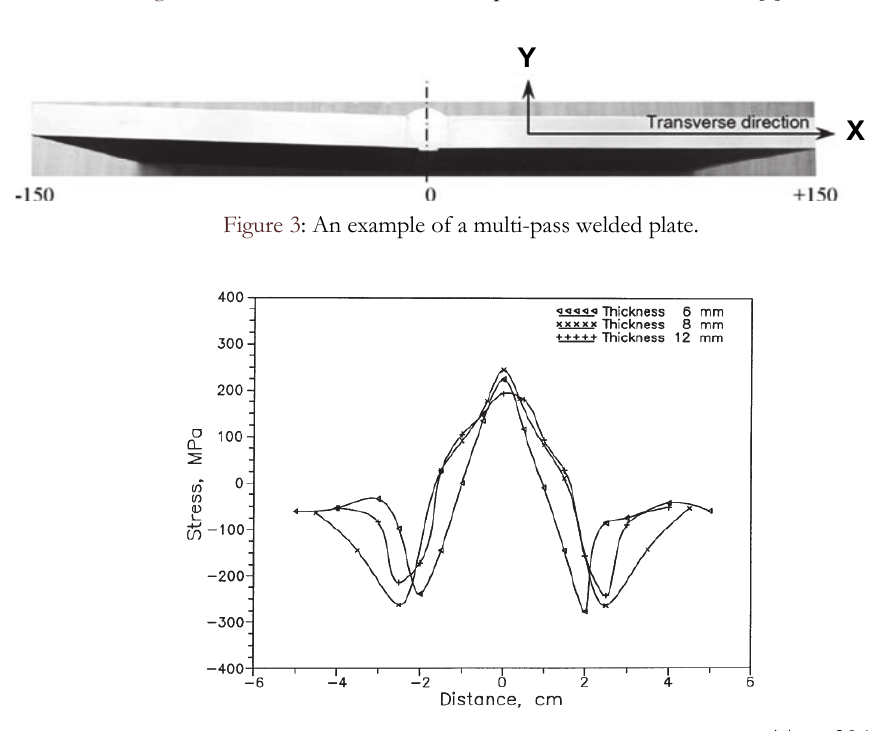
Figure 4: Illustration of the plate thickness effects on post-welding residual stress distribution in Type 304 stainless steel